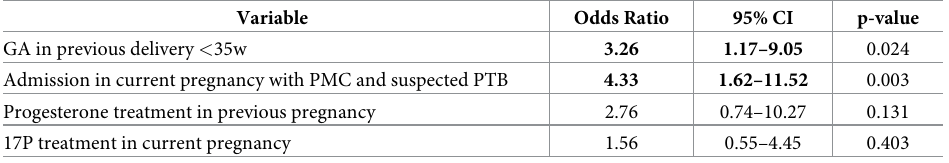
Table 3. Logistic regression: Risk factors for PTB < 35w in subsequent